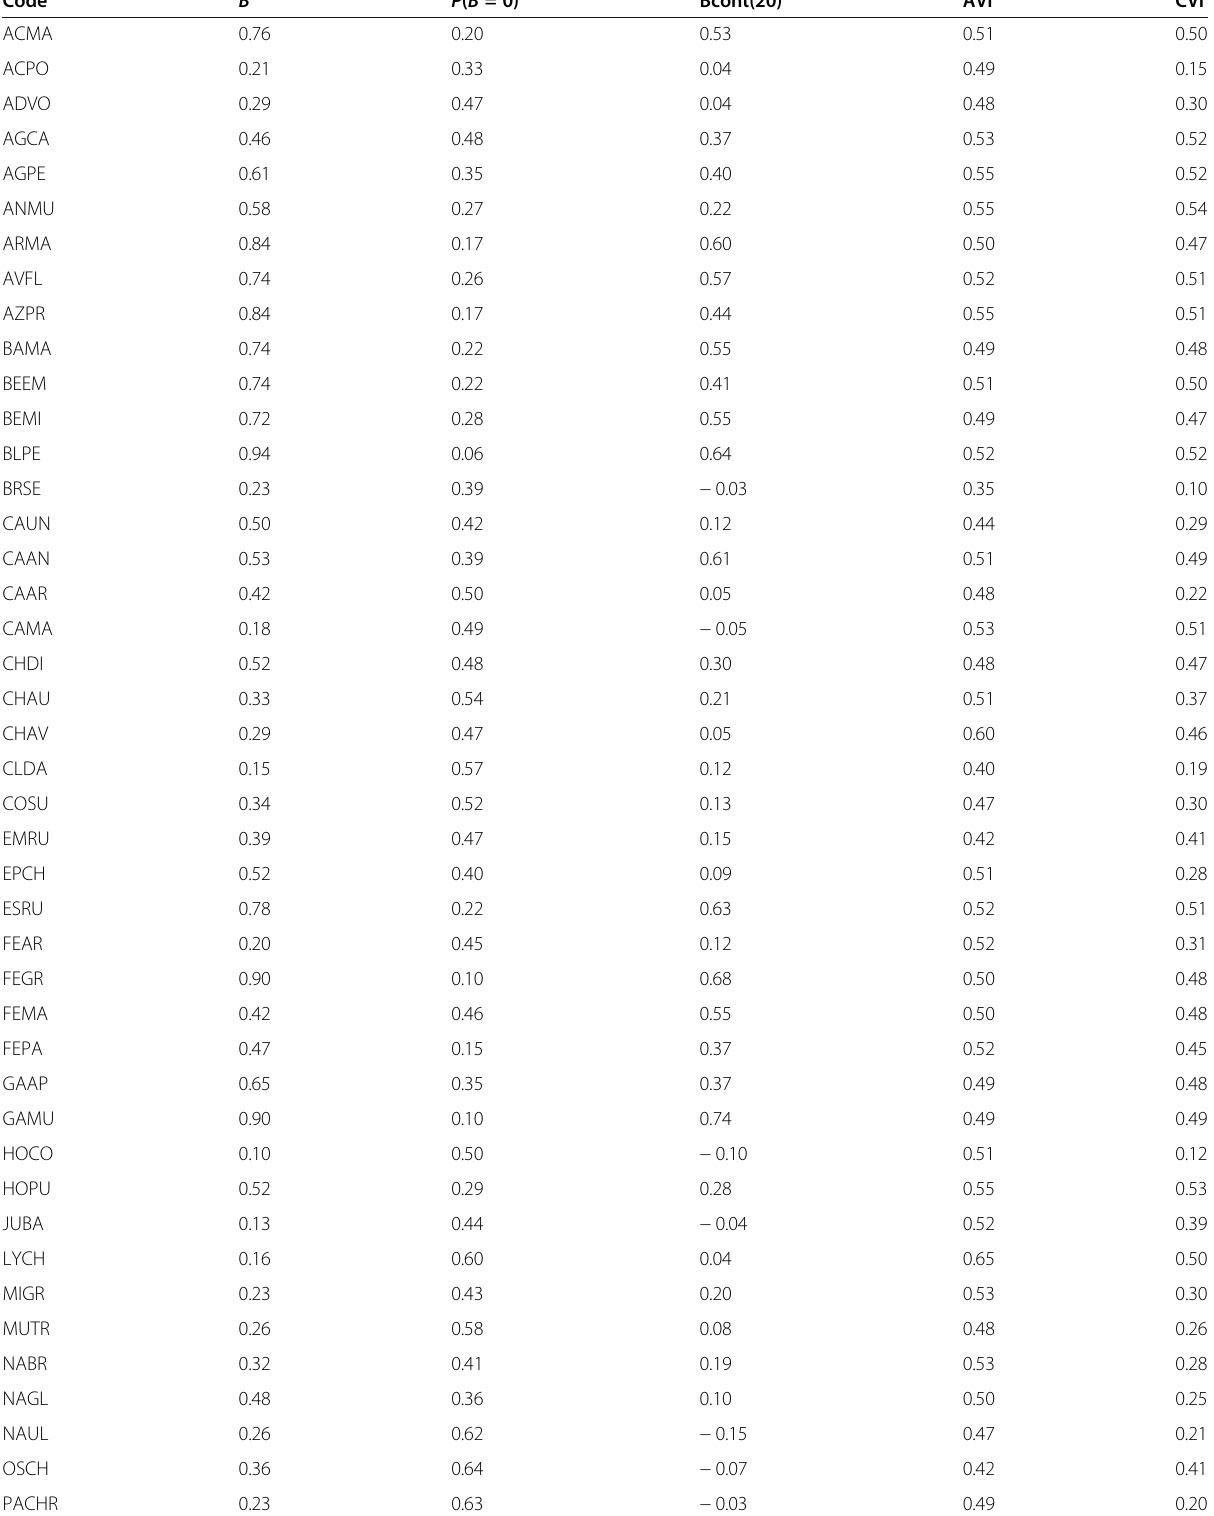
Table 7 Cross-validation values for each potential habitat suitability model of plant species of Santa Cruz